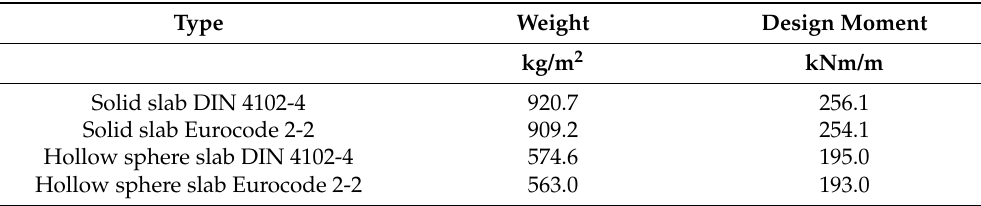
Table 2. Dead weight of the different slab types according to their design moment.